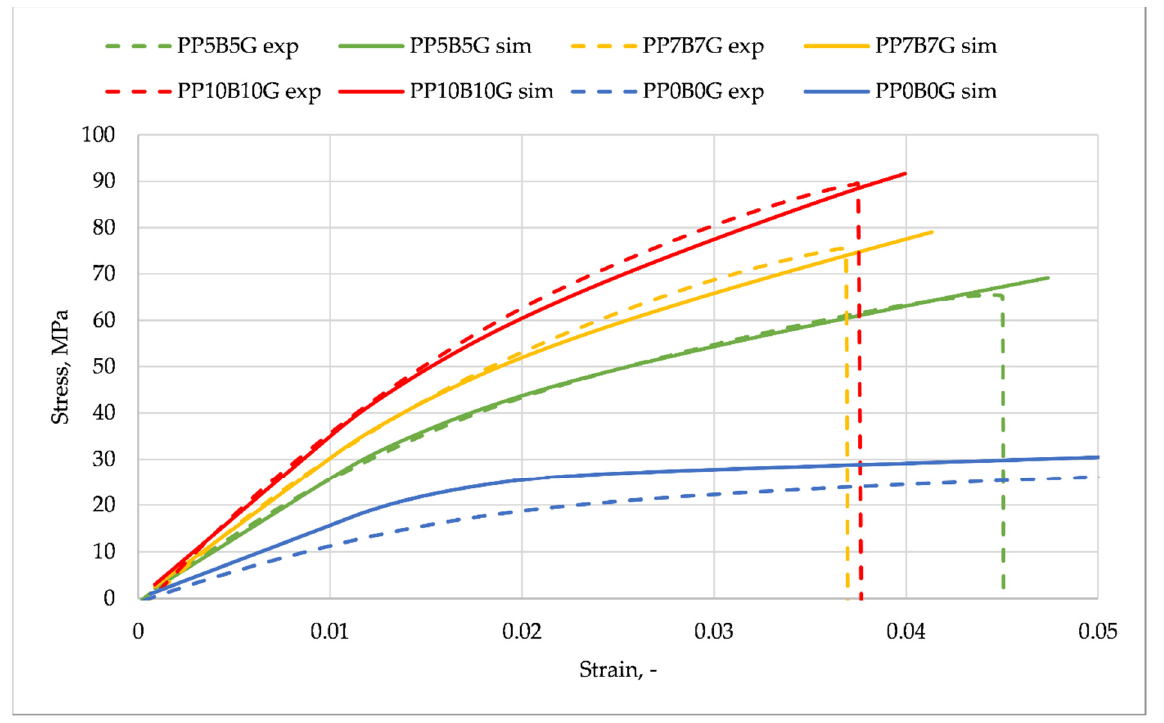
Figure 6. Cross-section of the specimen with visible stress distribution according to fiber orienta- tion.